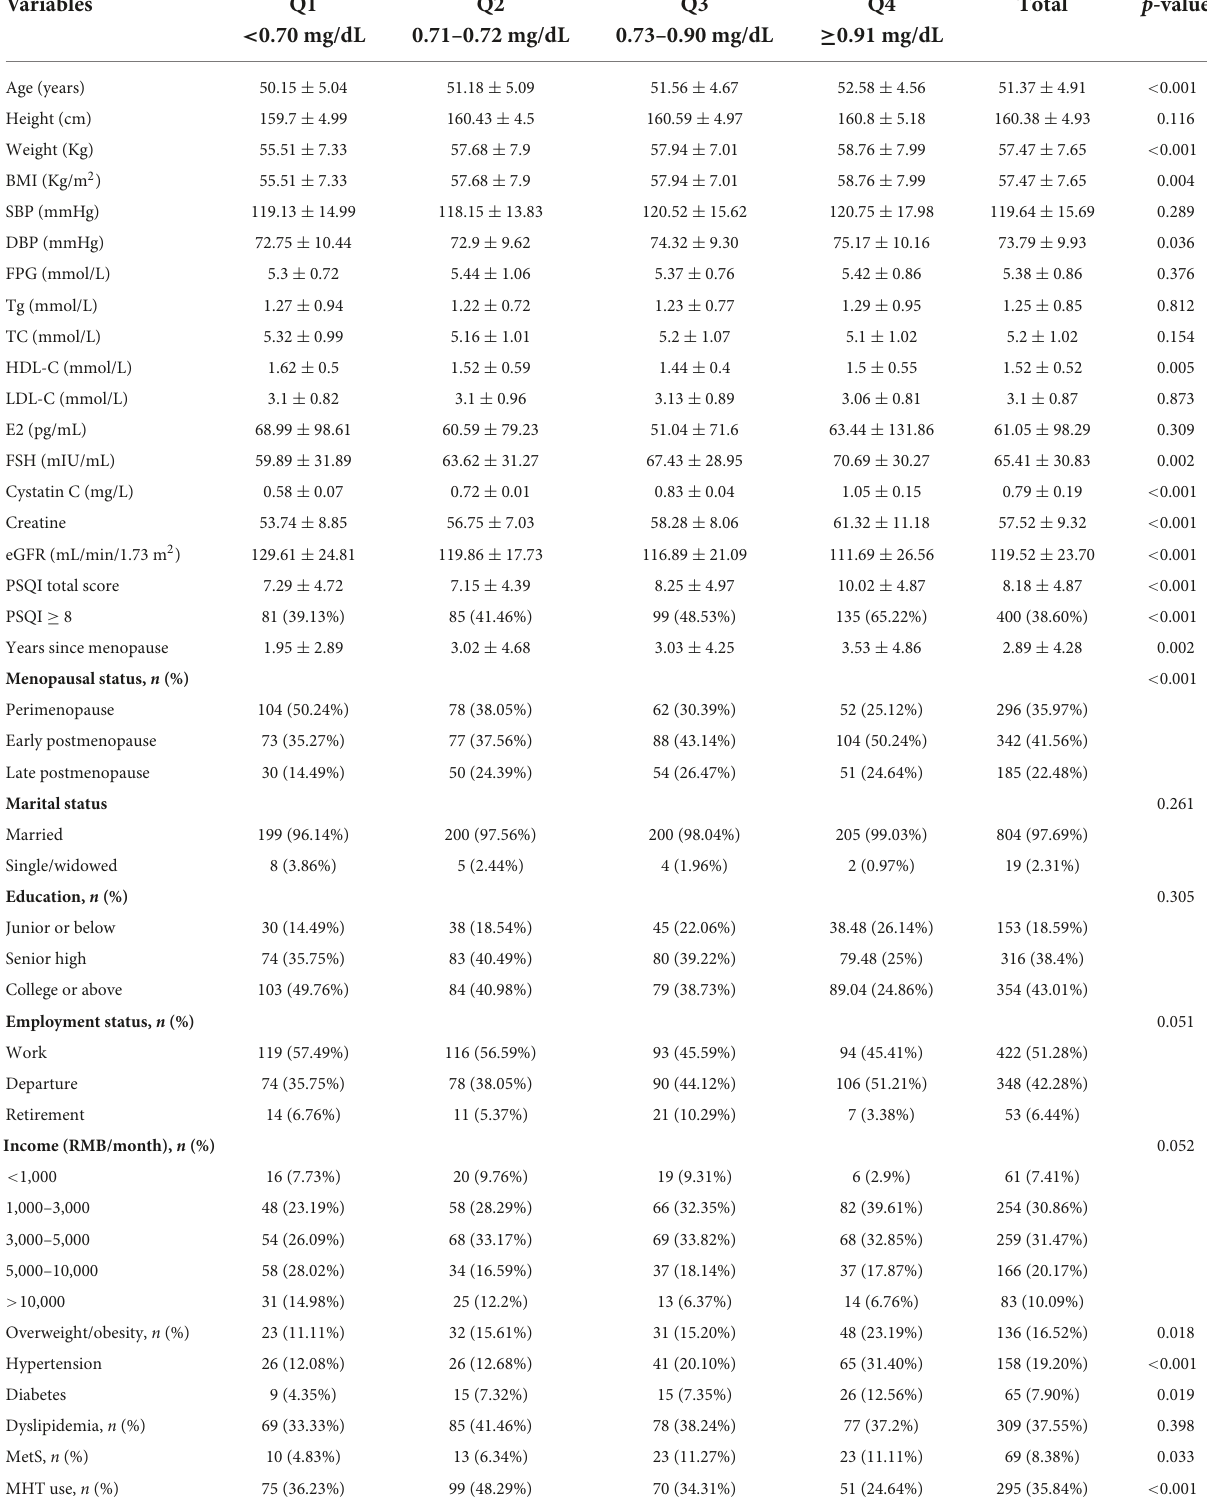
TABLE 1 Characteristics of the study participants distributed by quartile of cystatin